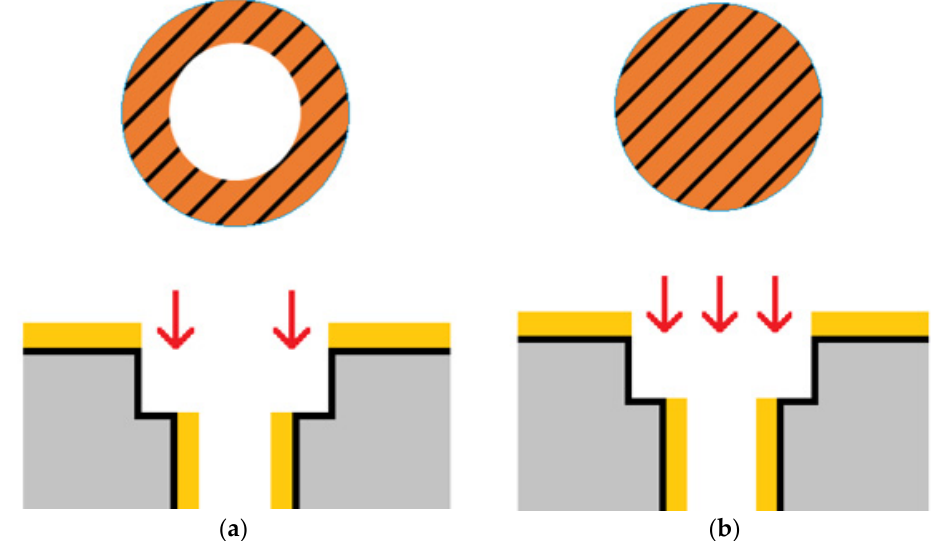
Figure 10. Two laser trimming strategies: ( a ) donut type and ( b ) circular type.